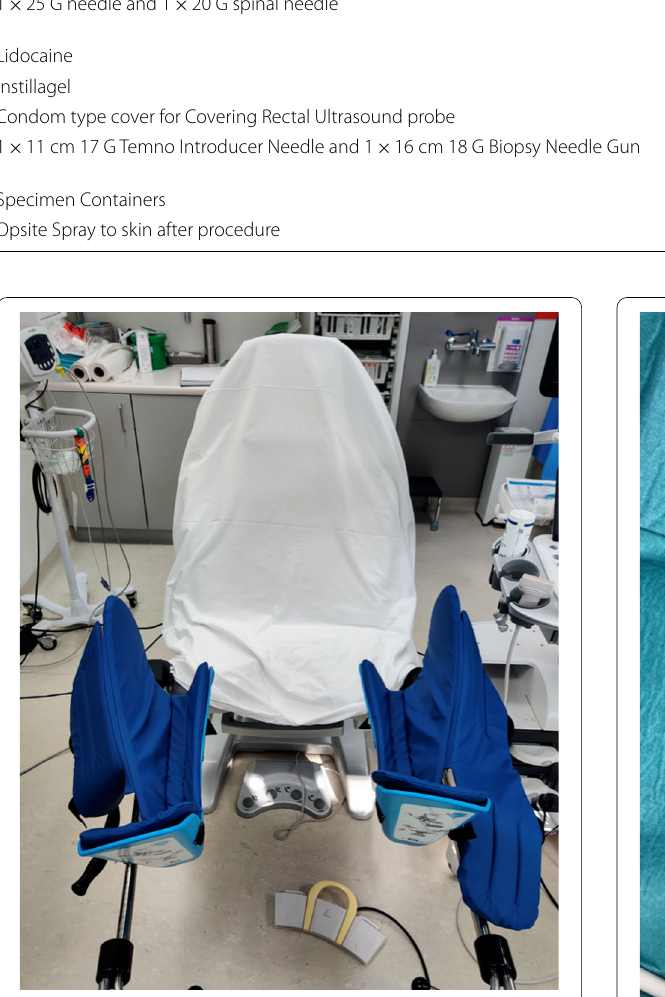
Fig. 1 Arco Matic 300 M electrically operated lithotomy Chair with fin type padded boot stirrups (Schmitz, Germany)